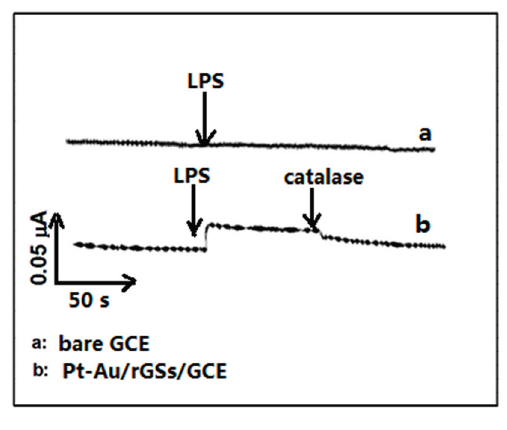
Figure 8. Amperometric responses at (a) bare GCE and (b) Pt-Au/rGSs/GCE in 0.1 M PBS containing PC 12 cells at the potential of 0 V with the addition of 5 µg·mL − 1 LPS and 200 units·mL − 1